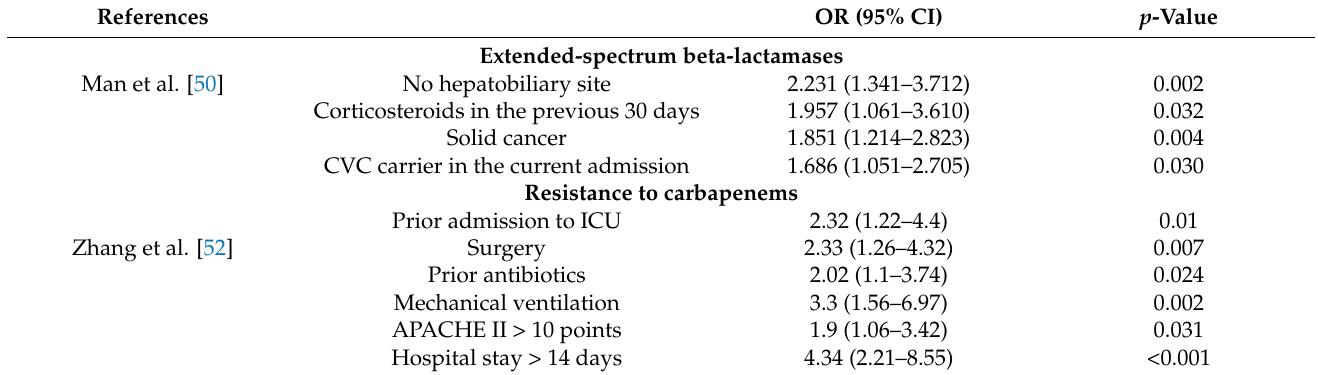
Table 3. Risk factors associated with the existence of resistance mechanisms in K. pneumoniae